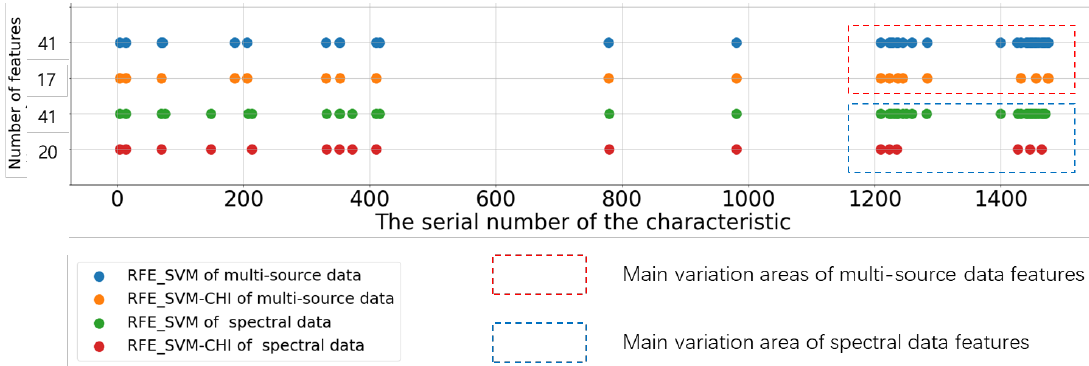
Figure 13. Feature selection results of four RFE_SVM algorithms.